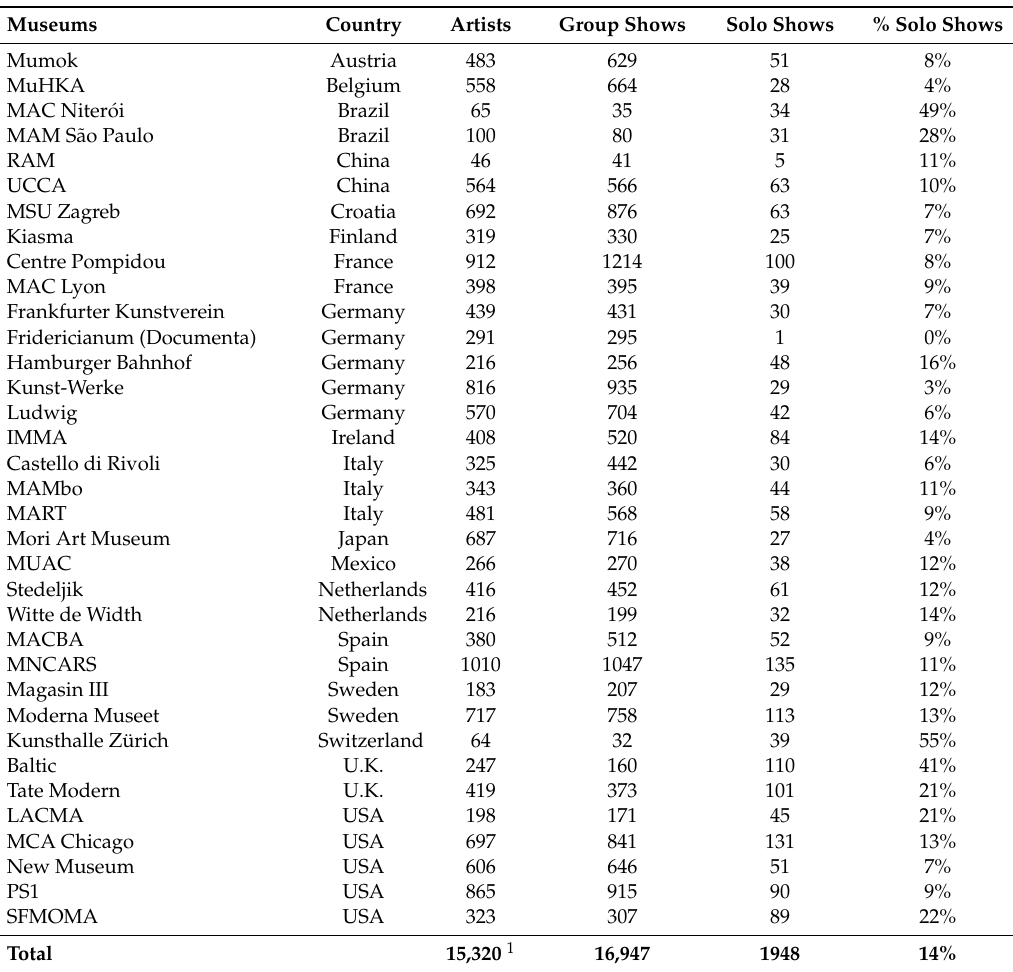
Table 6. Contemporary art museums and exhibition spaces in our